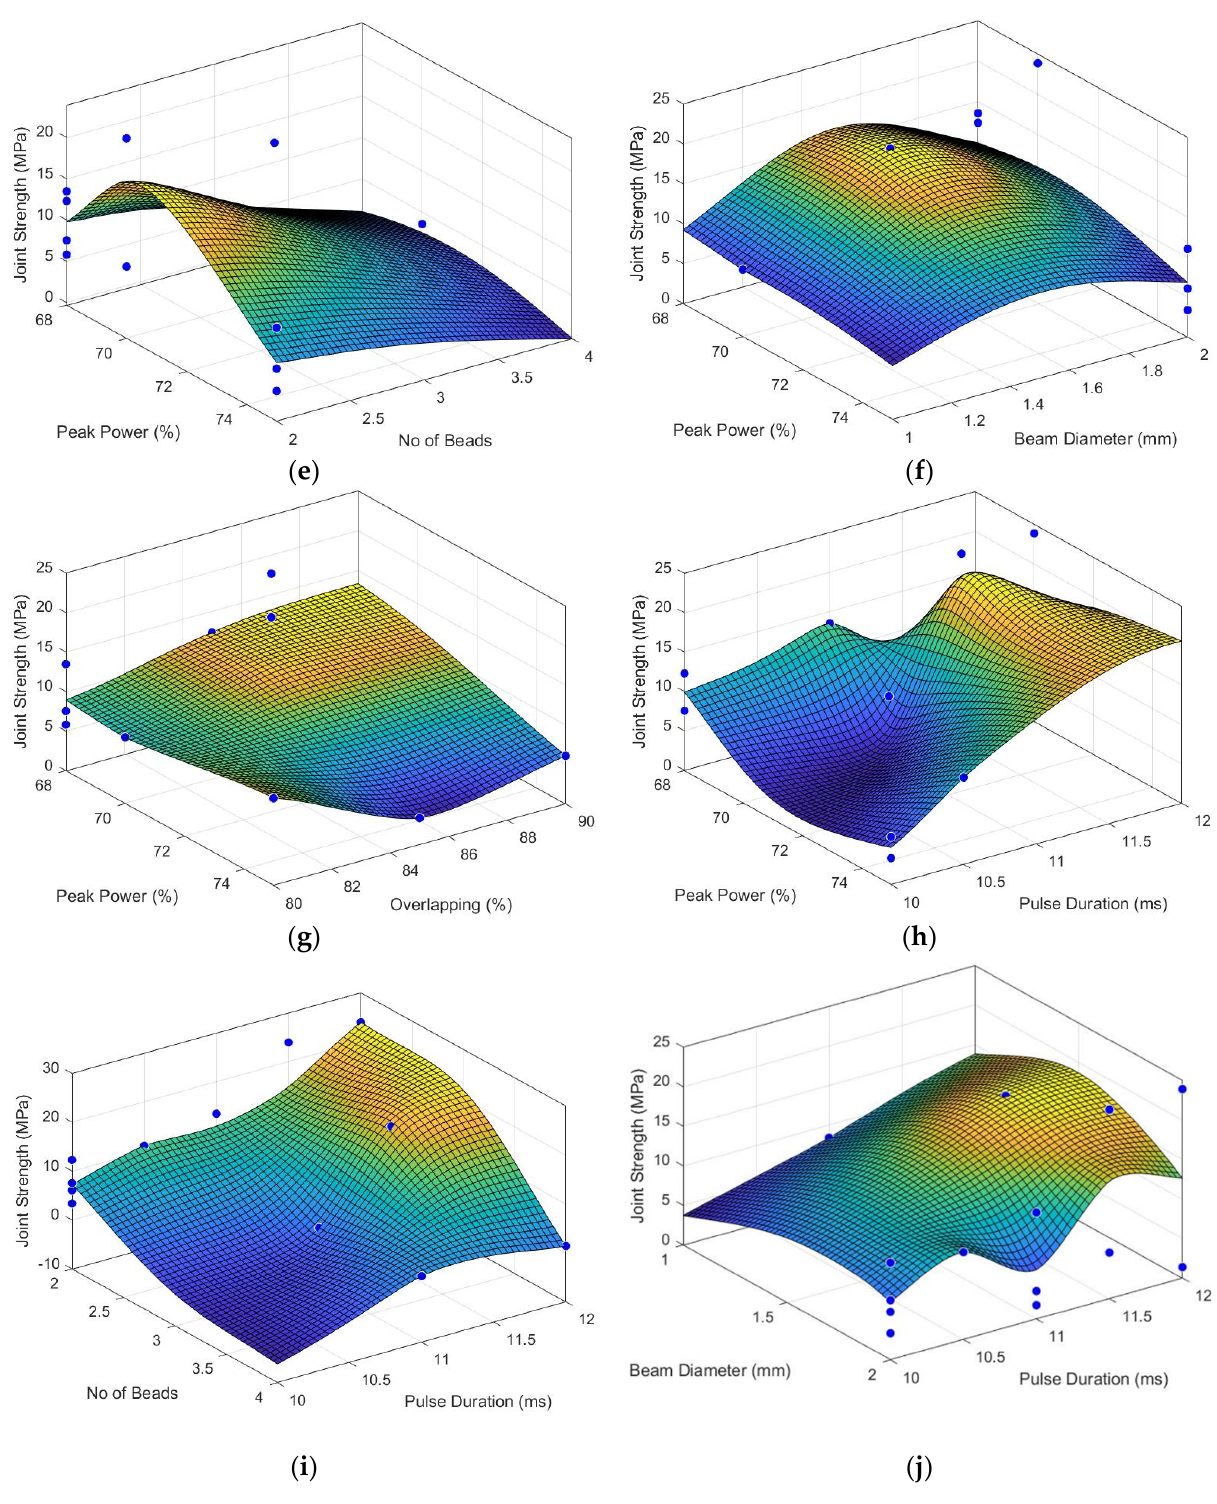
Figure 8. Joint strength evolution with the process parameters (blue dots represent results obtained for each set): ( a ) laser beam diameter and the number of beads; ( b ) laser beam diameter and percentage of overlapping; ( c ) the number of beads and percentage of overlapping; ( d ) percentage of overlapping and pulse duration; ( e ) peak power and the number of beads; ( f ) peak power and laser beam diameter; ( g ) peak power and overlapping; ( h ) peak power and pulse duration; ( i ) number of beads and pulse duration; ( j ) laser beam diameter and pulse duration.